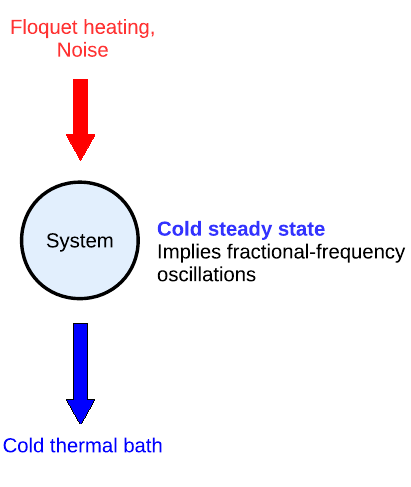
FIG. 2. So long as the energy inflow due to noise and periodic driving is balanced by the outflow to a cold thermal bath, giving a low-energy steady state, oscillations at a fraction of the drive frequency will be